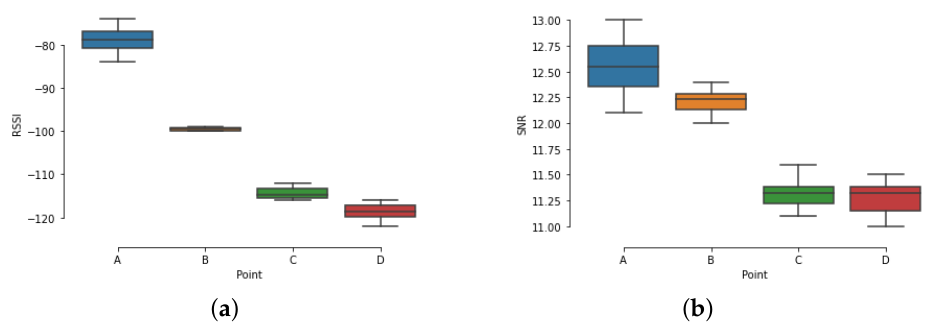
Figure 32. Average RSSI and SNR per LoRaMESH point. ( a ) RSSI. ( b )